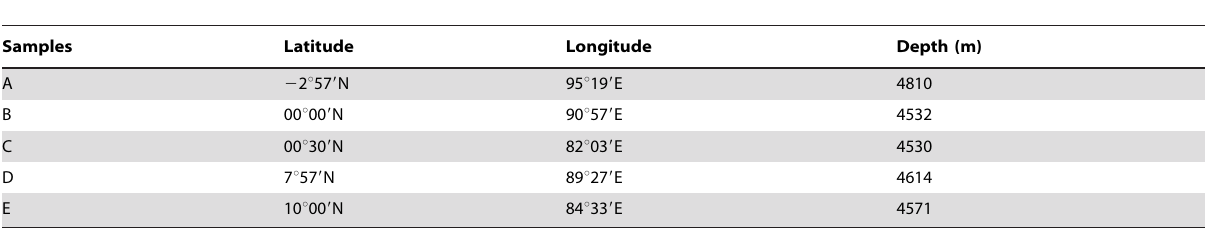
Table 1. The coordinates of Sample A–E.